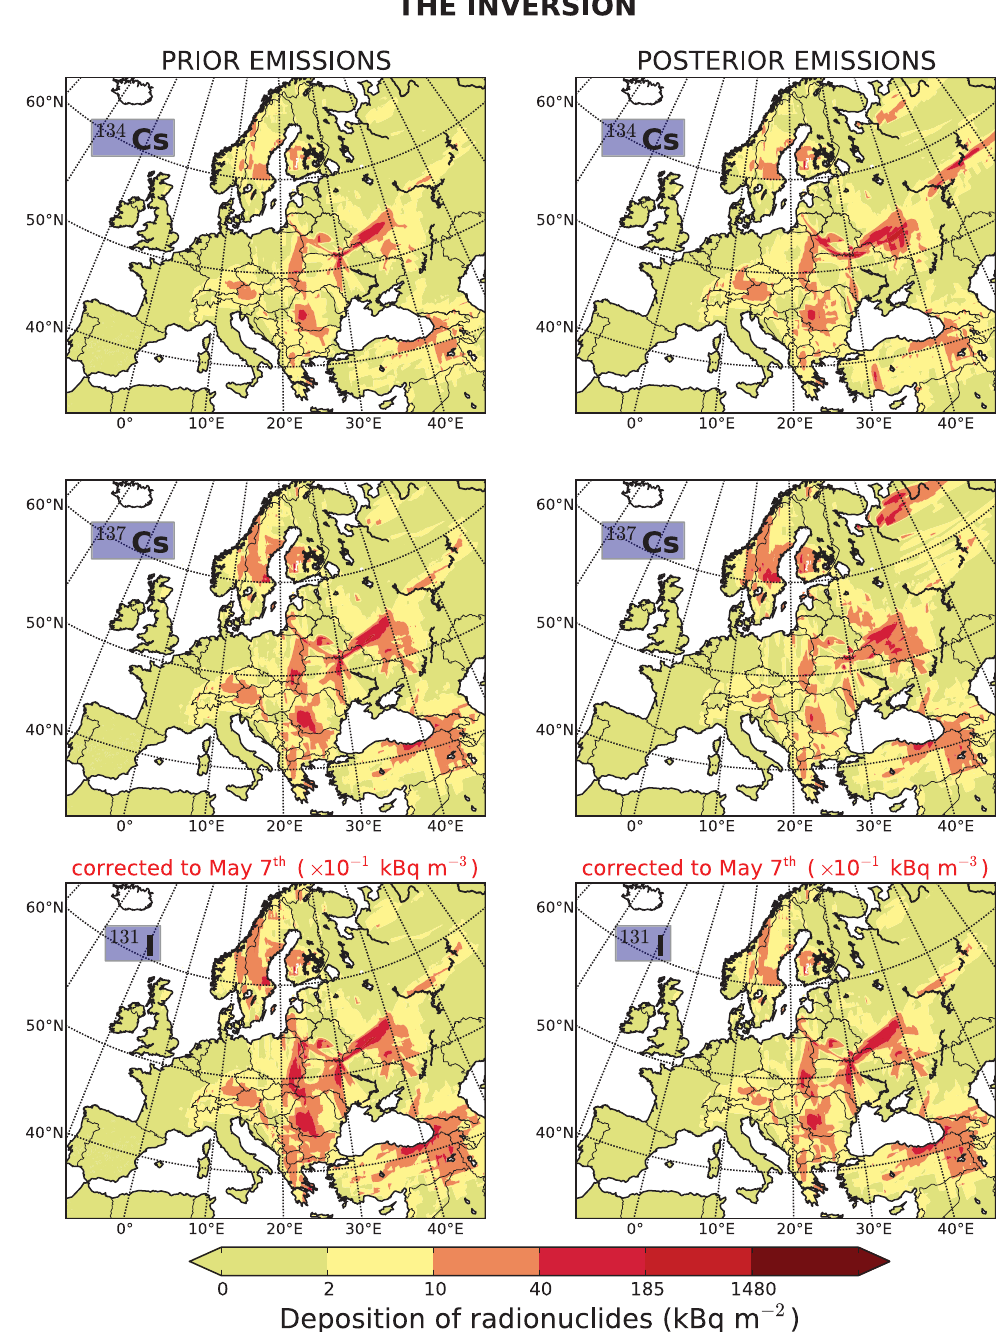
Figure 6. Cumulative deposition of 134 Cs, 137 Cs and 131 I using prior (left column) and posterior emissions (right column). Note that deposition of 131 I was corrected for radioactive decay to the end date of the releases (7 May). Considering that emissions of 131 I were about 20 times higher than those of 134 Cs and 137 Cs, total cumulative deposition of 131 I was scaled by a factor 0.1 in order to be able to use the same color scale as for the other